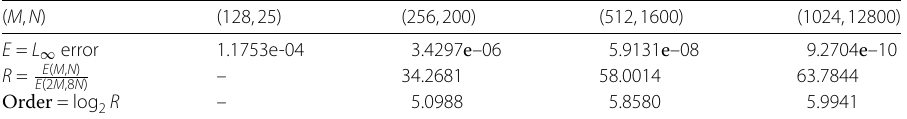
Table 3 Order of convergence for the European put options under the Merton model by the CCD method with λ = 0.1 and S = 30